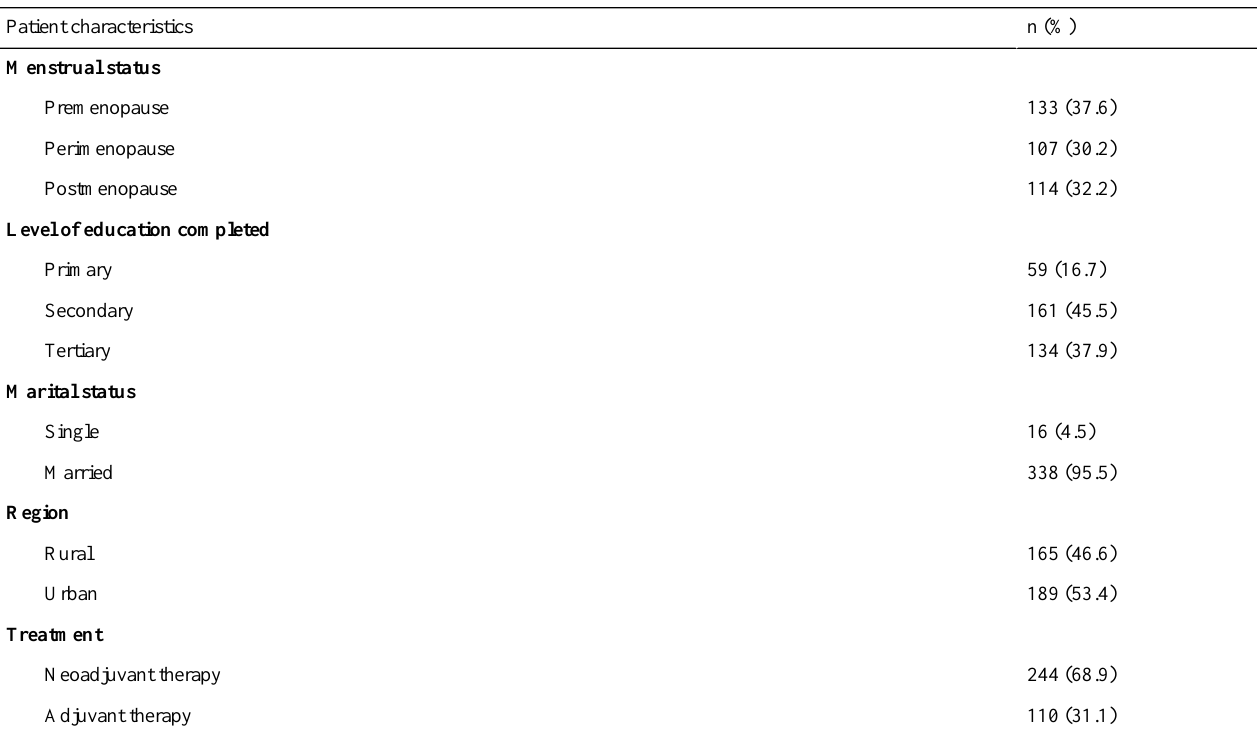
Table 1. Basic characteristics of study